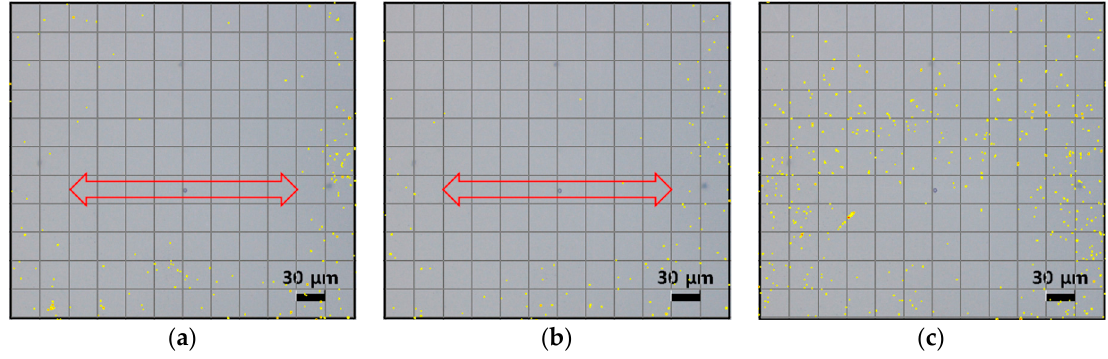
We increased the number of applied pulses to 1000 while maintaining a 20 μ m gap distance, as shown in Figure 15. When the number of pulses was 500, the cleaning effi- ciency was similar to the case of 110 pulses. However, more particles appeared for the 1000 pulse case. As in the previous case when the pulse number was 20,000, accumulated heat resulted in thermal damage to the glass substrate, and broken glass particles were formed. Both the gap distance and the applied pulse number should be selected carefully Figure 14. Particle distribution analysis of Figure 13. Figure 14. Particle distribution analysis of Figure 13. to avoid damage to the glass substrate.